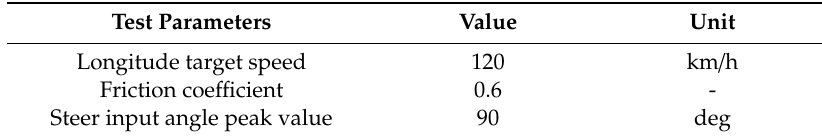
Table 9. Main parameters of DLC test.